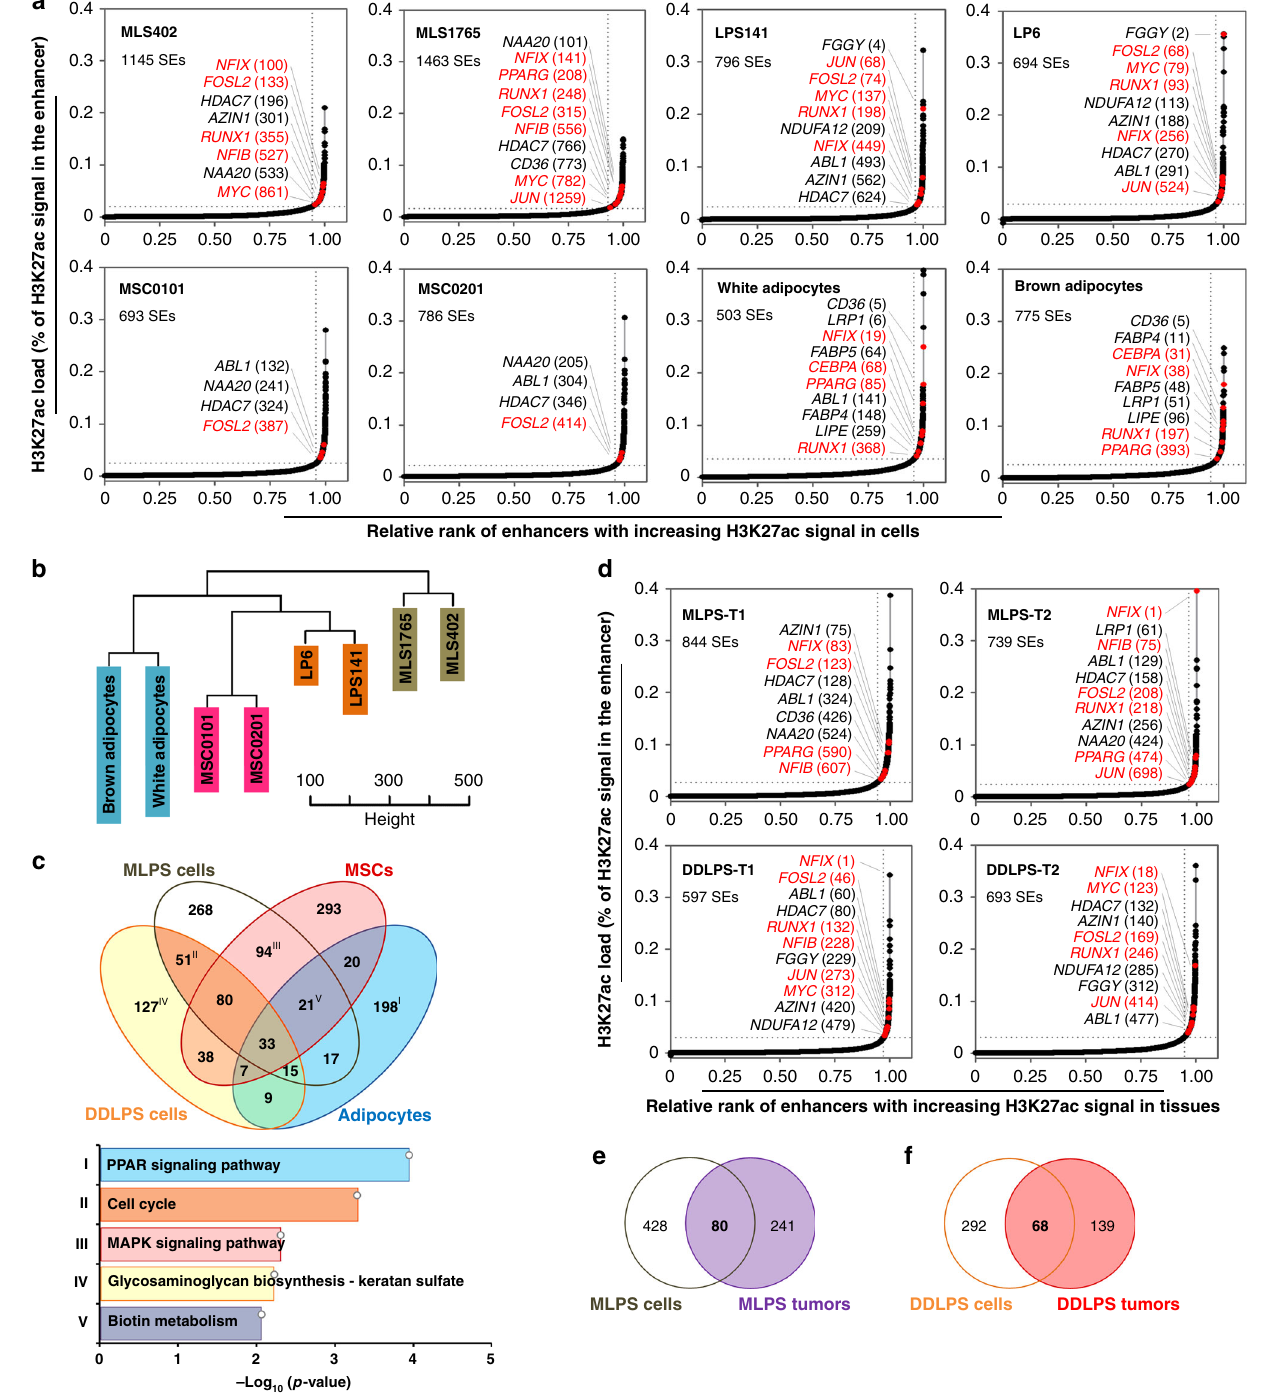
Fig. 1 Super-enhancer pro fi ling in de-differentiated LPS (DDLPS) and myxoid LPS (MLPS). a Relative rank of stitched H3K27ac ChIP-seq signals in adipocytes, mesenchymal stem cells (MSCs), DDLPS (i.e., LPS141 and LP6) cells, and MLPS (i.e., MLS402 and MLS1765) cells. Representative super- enhancer (SE)-associated genes and their rankings in parentheses were highlighted. Transcription factors were marked in red. b Unsupervised clustering of SE regions across the eight cell lines. Colors represent cell types. c Venn-diagram showing common and cell-type-speci fi c SE-associated genes across eight cell line samples. SE-associated genes that were present commonly in same cell types were compared. Lower panel indicates top KEGG pathways by which genes from indicated categories were overrepresented (hypergeometric test). d Relative rank of stitched H3K27ac ChIP-seq signals in primary DDLPS and MLPS tissues. e , f Venn-diagram showing common and sample type-speci fi c SE-associated genes across ( e ) MLPS and ( f ) DDLPS. SE-associated genes that were present commonly in either cell lines or fresh tumors of same subtype were compared. Source data are provided as a Source Data fi